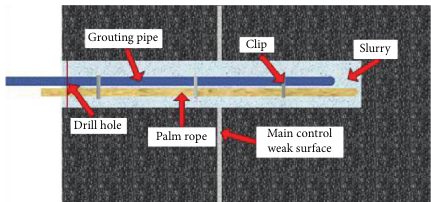
Figure 18: Construction diagram of the “coir rope plus grouting” flexible protection technique.